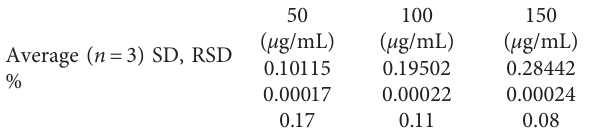
Table 4: Interday analysis of SRP (analyst 1).